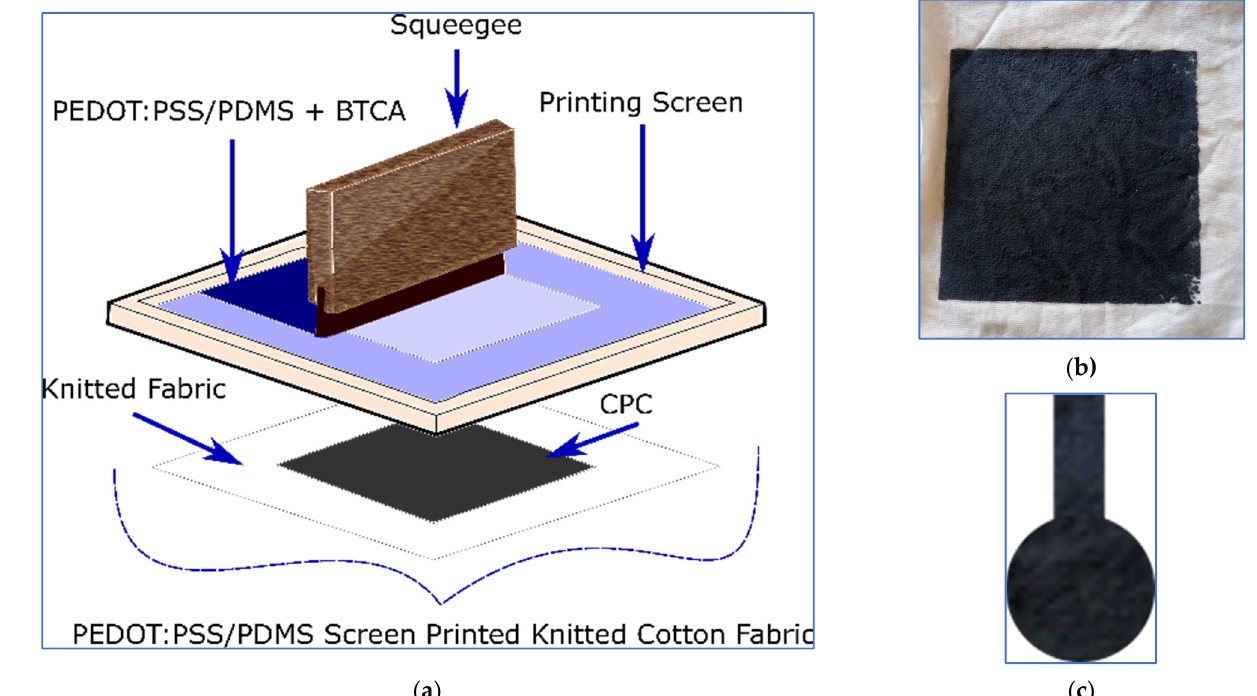
Figure 7. ( a ) The schematic illustration of flat screen printing [21], under CC by 4.0; ( b ) PEDOT/PSS/PDMS-printed knitted cotton fabric; and ( c ) actual EEG textile electrode. cotton fabric; and ( c ) actual EEG textile